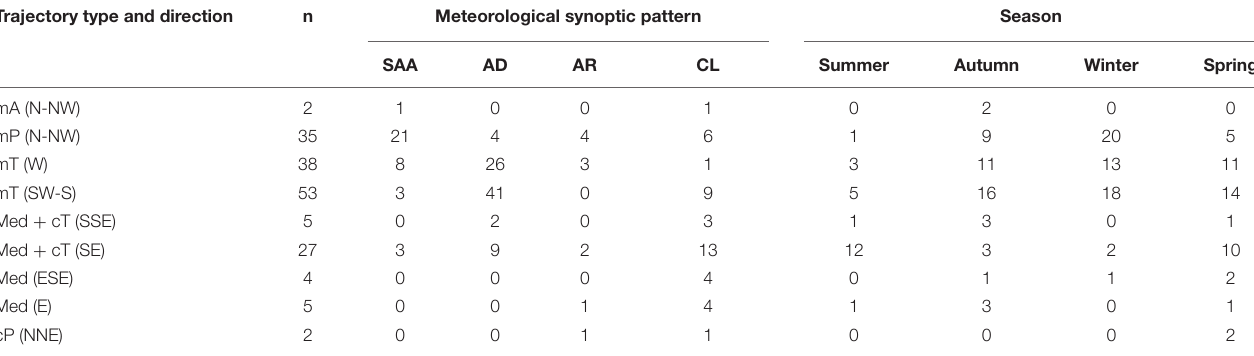
TABLE 5 | Number of events that correspond to the different synoptic patterns analyzed and to the different seasons, indicated for each trajectory type and direction. Trajectory type and direction n Meteorological synoptic